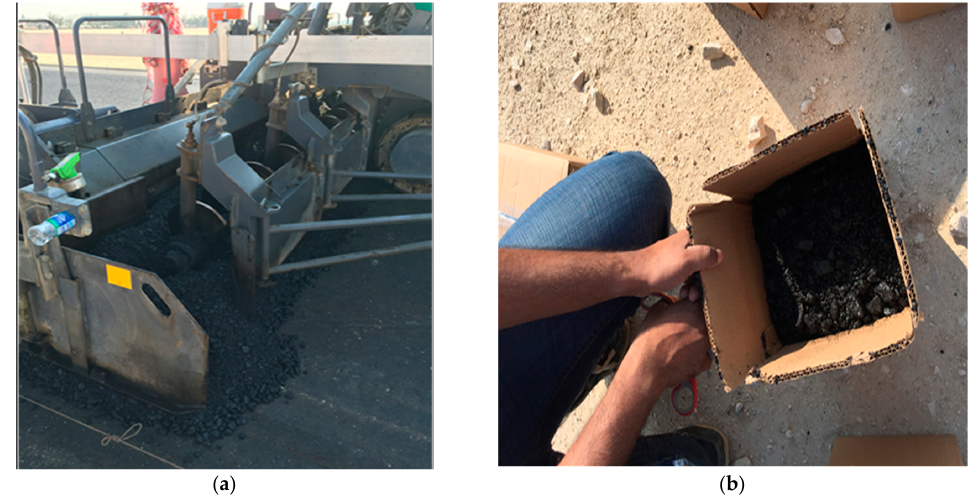
Figure 1. ( a ) Asphalt paver and ( b ) collection of loose mixtures.